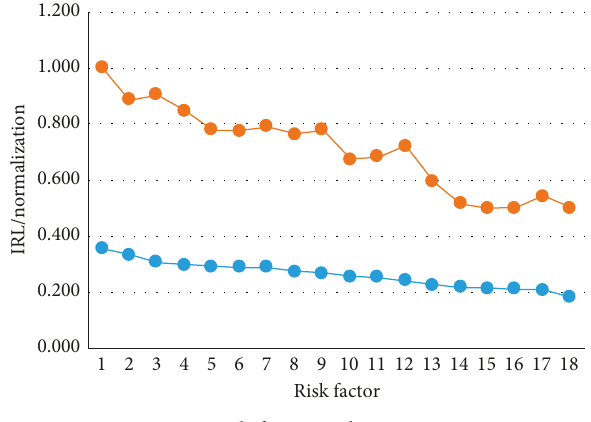
Figure 2: Risk factor rank comparison.